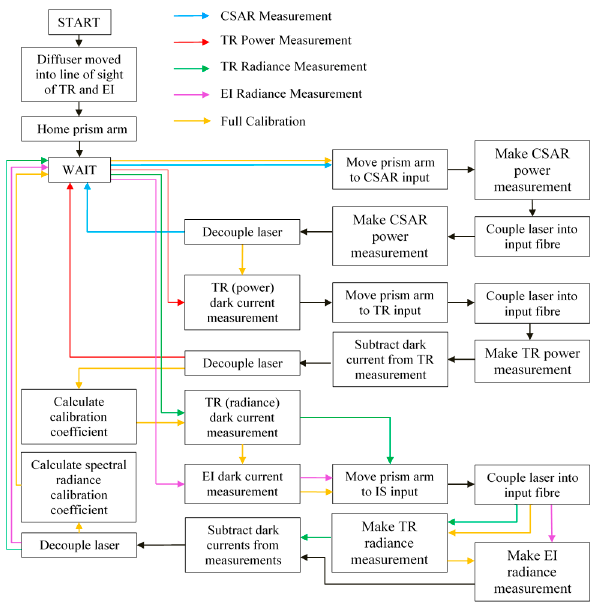
Figure 8. The TRUTHS calibration system calibration sequence.